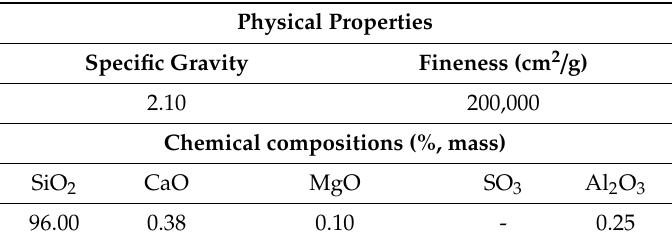
Table 2. Physical and chemical properties of silica fume.